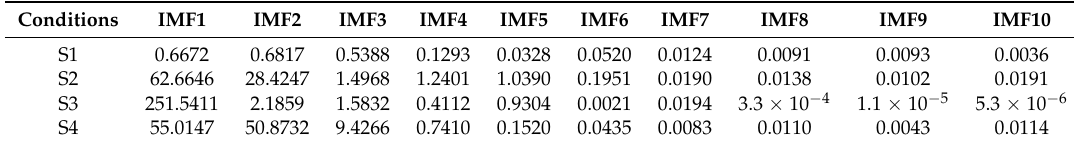
Figure 10. Vibration signals collected from Sensor 6 and the decomposition results of EEMD: ( a ) normal IMFs; ( b ) IMFs of inner-race fault; ( c ) IMFs of ball fault; ( d ) IMFs of outer-race fault. Table 2. CCRF values of IMFs decomposed from vibration signals collected by Sensor 6.